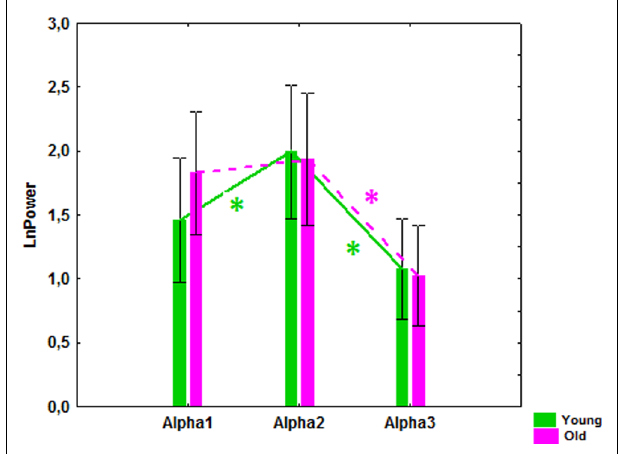
FIGURE 2 |Alpha1, alpha2, and alpha3 absolute power (mean and SE) in the healthy young and old cohorts. * P ≤ 0.01, significant differences between the alpha bands in the young (green) and old (purple)